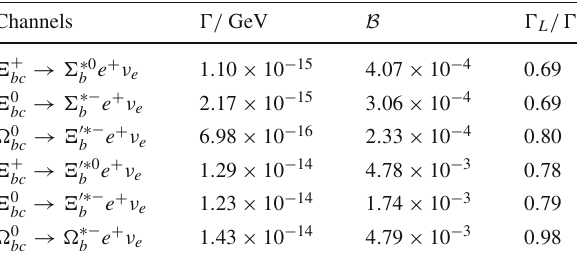
Table 12 Semileptonic decays for the bc sector with c quark decay